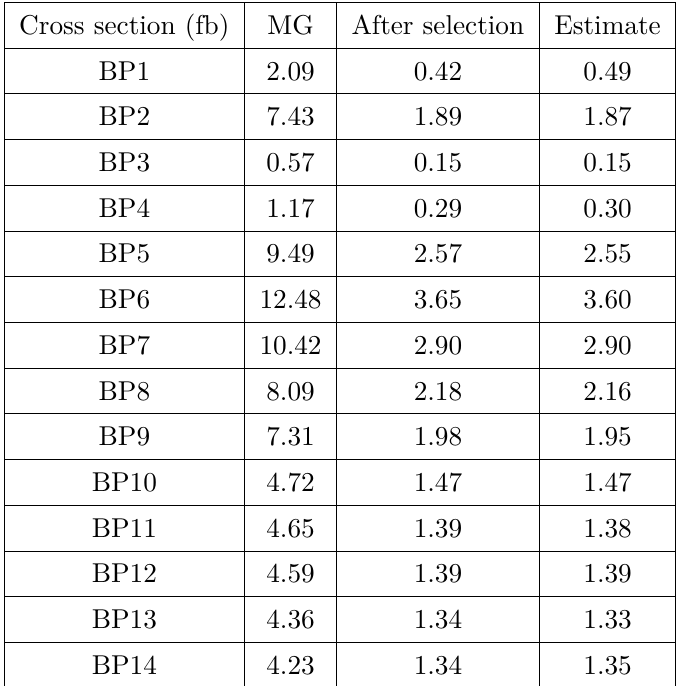
√ s = 13 TeV are given, after taking into